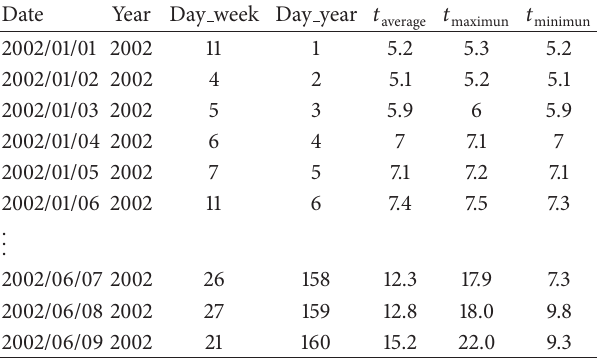
Table 1: Formatof thetemperatures file( ∘ C).Fragment of year